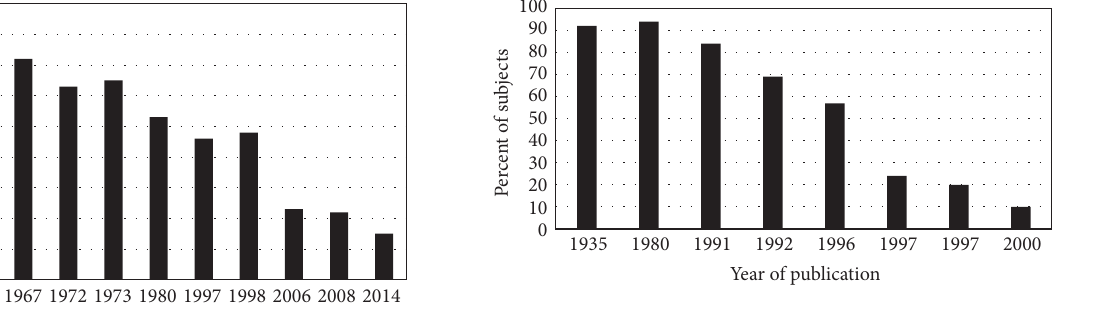
Figure 3: Cirrhosis in nonscreening hemochromatosis. Percentages of patients diagnosed to have hemochromatosis phenotypes who also had cirrhosis [3, 8, 169, 173–177]. There were two such reports from 1997. HFE mutation genotyping was a diagnostic adjunct in the more recent study [3]. Modified from [25, 178]. Greater proportions of men than women had cirrhosis. See cirrhosis prevalence in screening hemochromatosis cases in Figure 4.